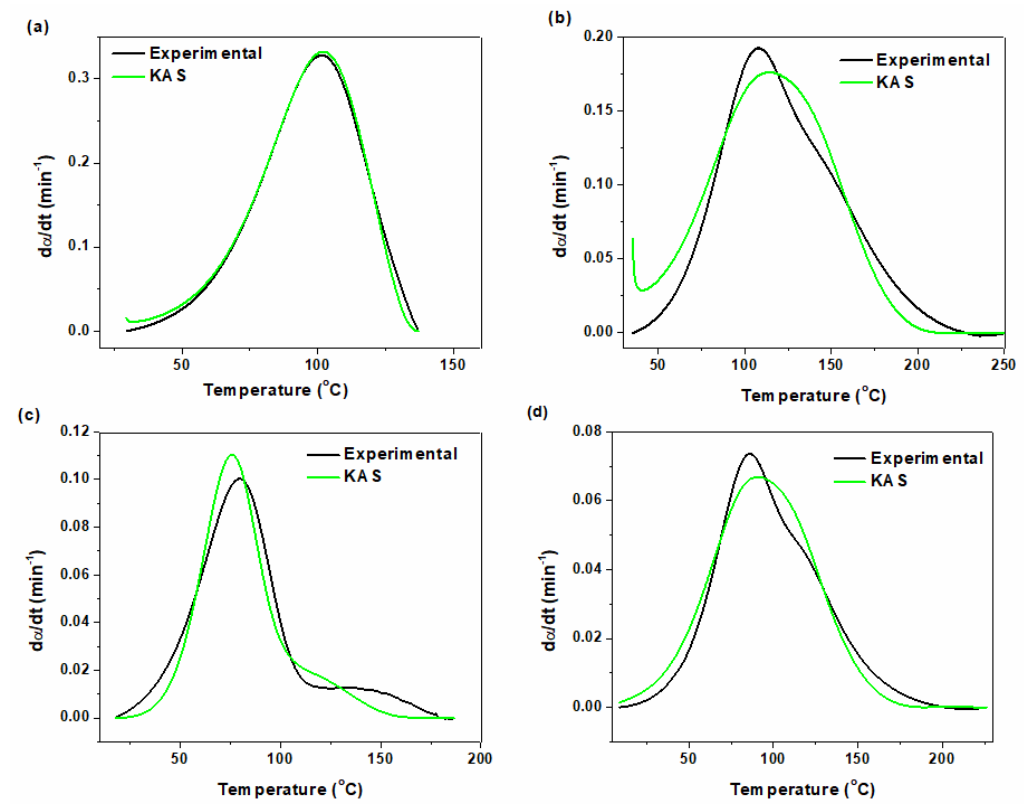
Figure 13. Comparison of experimental data with the kinetic models for ( a ) neat epoxy, ( b ) epoxy / P-HNT, ( c ) epoxy / A-HNT and ( d ) epoxy / F-HNT based on KAS model.